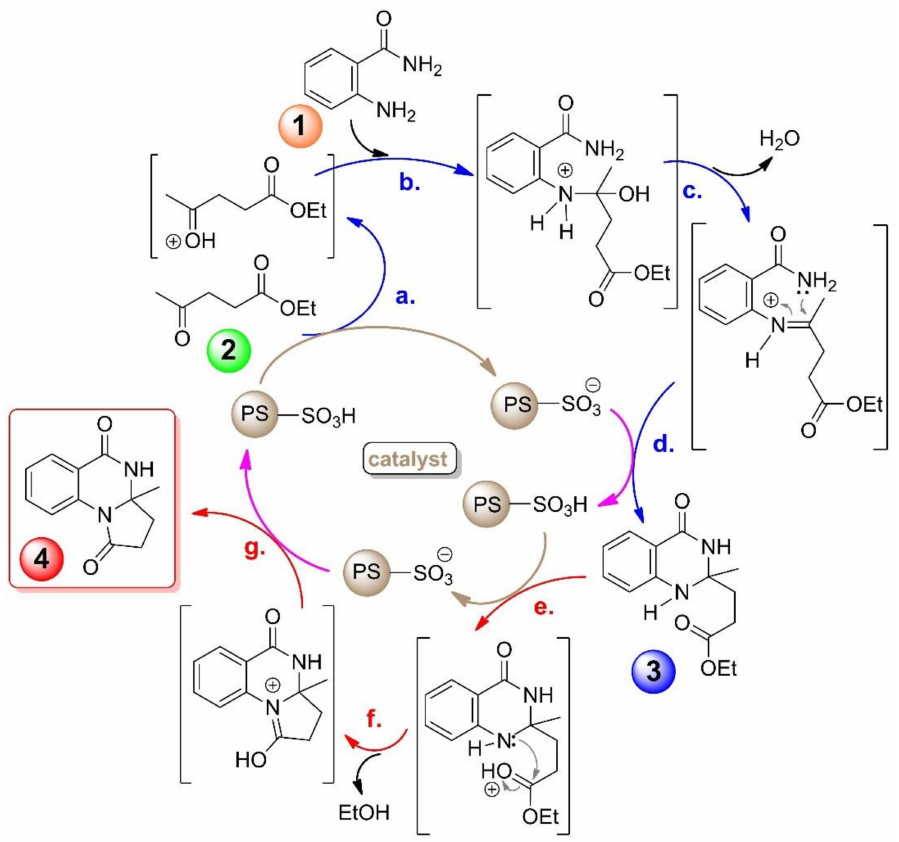
Scheme 2. The reaction mechanism of the cascade reaction: blue arrows are the catalytic steps which occurred thermally ( a .– d .) and the red arrows are steps requiring an acid catalyst ( e .– g .).